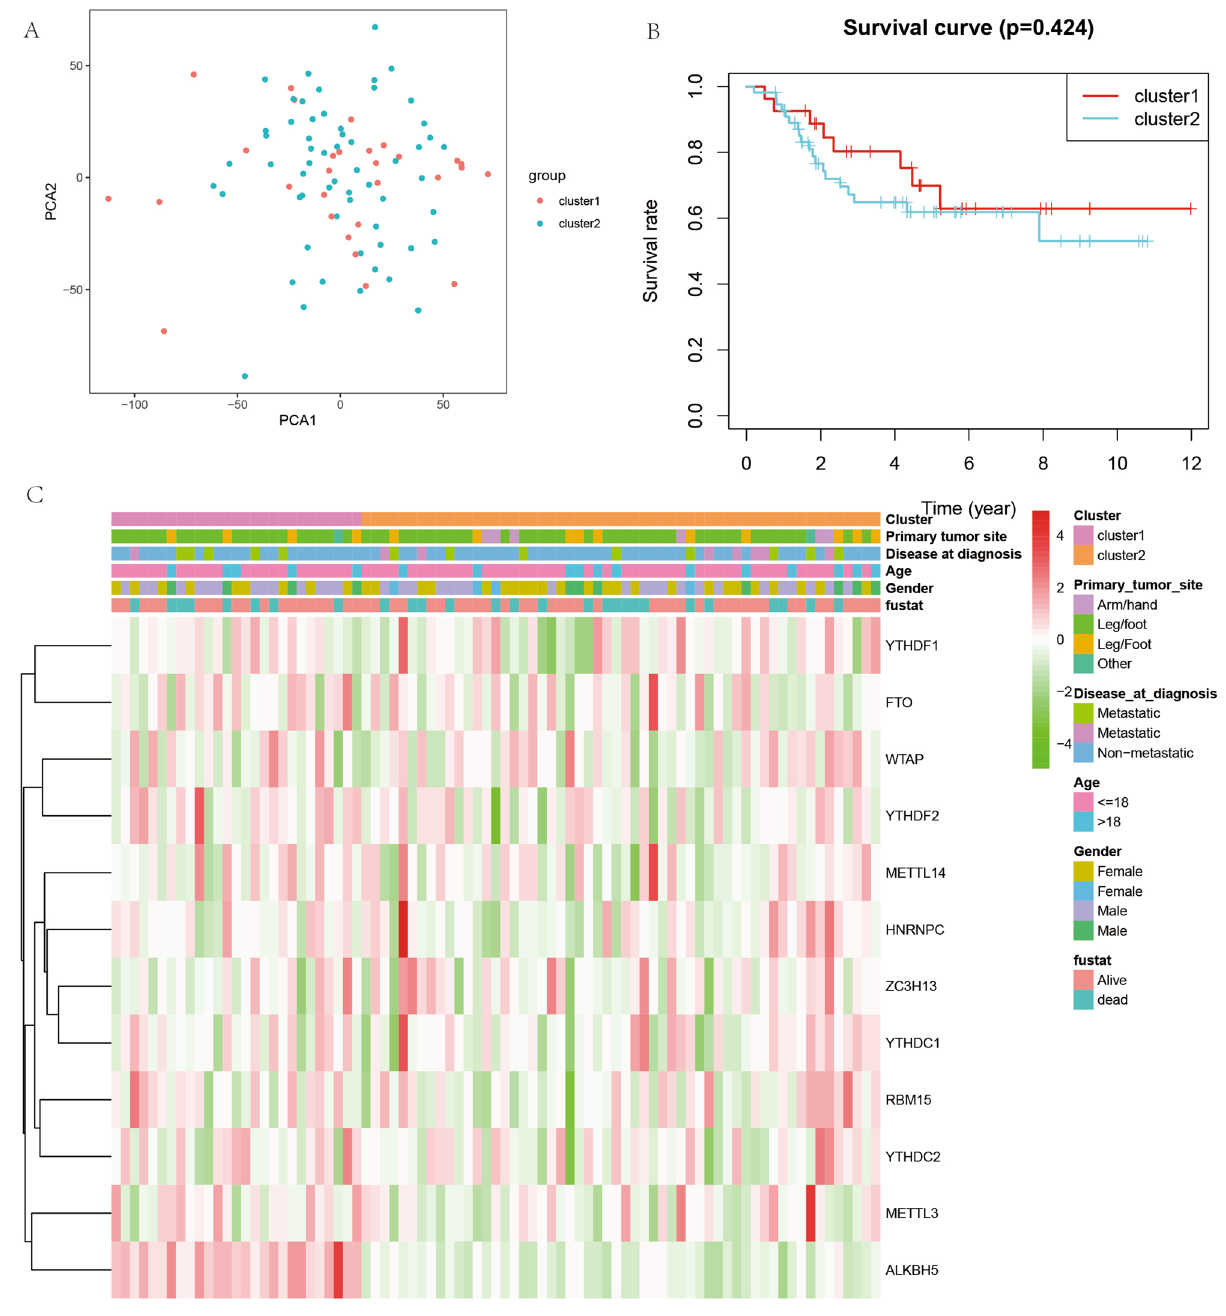
Figure 5. Principal component analysis, prognostic analysis and clinical correlation analysis of m6A-related genes based on tumor typing. ( A ) Shows the principal component analysis. ( B ) Shows the KM curves of the prognostic analysis constructed based on two different cluster groupings. ( C ) Represents the clinical correlation analysis based on two different